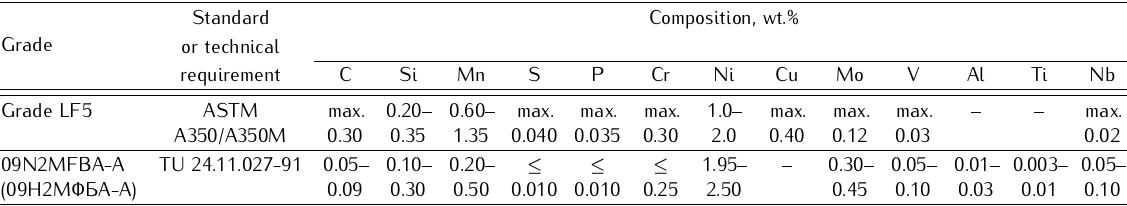
Table 1. Chemical composition of steels used in the production of spent fuel transport and storage casks.